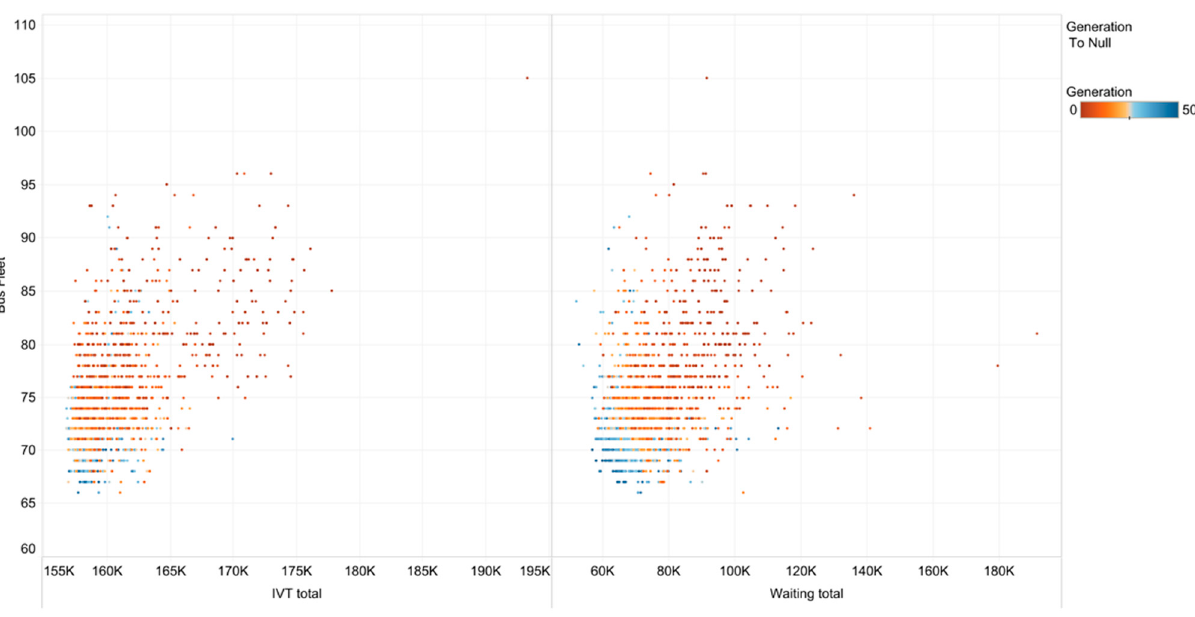
Figure 6. Pareto Optimal solutions for different bus fleets (red dots).